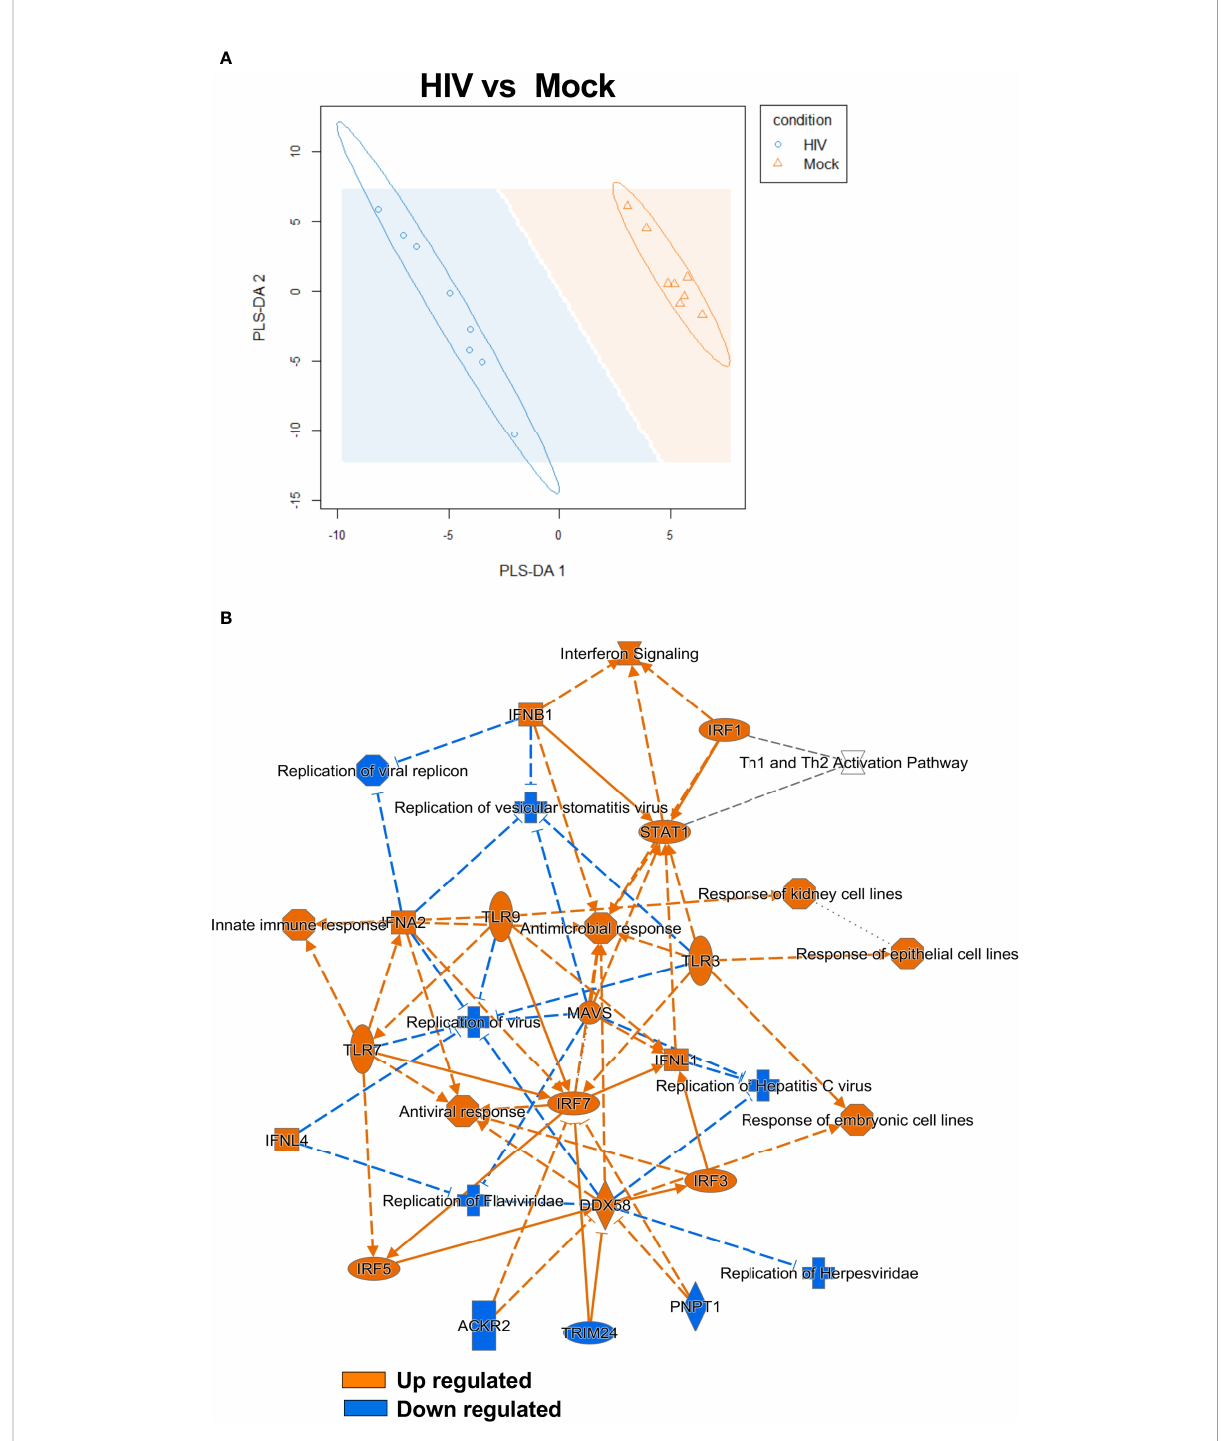
FIGURE 6 Transcriptomic data revealed a clear type I IFN signaling pro fi le in HIV exposed DC cocultures. PLS-DA analysis was performed to model relationship between HIV exposed and unexposed HIV DCs after coculture with T cells (N=8) (A) . Transcriptomic data set including 8 individual donors/experiments were analyzed using Ingenuity Pathway Analysis (IPA). IPA selected pathways were visualized as network with a threshold for p-values set to -log 1.3 (p<0.05) and presented as positive activation Z-score in orange and negative in blue (B)